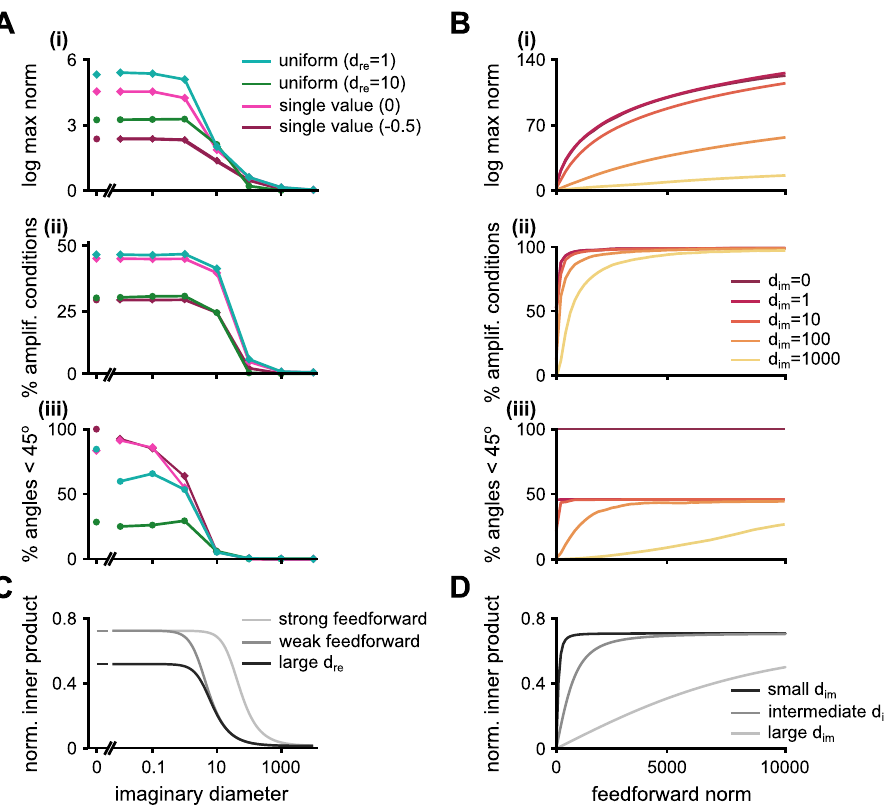
Fig 3. Effects of manipulating the spectrum and the feedforward norms. A , Maximum response norm for the preferred initial condition (i) , percentage of directions whose norm is amplified more than 50% (ii) , and the percentage of angles (between pairs of eigenvectors) that are less than 45˚ (iii) . Every line is a function of the imaginary diameter. We plot four real distributions. Light green: a uniform distribution in which all real parts are distributed uniformly in the interval ( − 0.5, 0.5). Dark green: a uniform distribution in which all real parts are distributed uniformly in the interval ( − 9.5, 0.5). Light pink: a single valued real distribution in which all real parts are equal to zero. Dark pink: a single valued real distribution in which all real parts are equal to − 0.5. In all cases the network size is N = 200 and the feedforward Frobenius norm is fixed at 75. d re indicates the diameter of the uniform distribution of the eigenspectrum’s real part. B , Same as panel A, but plotted as a function of the feedforward Frobenius norm. Different colours correspond to 5 different spectra; all spectra have fixed single-valued real distributions (equal to zero) and different imaginary diameters. d im indicates the diameter of the uniform distribution of the eigenspectrum’s imaginary part. C , Normalised inner product between vectors from a simplified 3-by-3 upper triangular matrix (Eq 4) as a function of the imaginary diameter ( β in Eq 4) for three conditions: “strong feedforward” ( ϕ norm = 30 and α − γ = − 0.3); “weak feedforward” ( ϕ norm = 3 and α − γ = − 0.3); and “large d re ” ( ϕ norm = 3 and α − γ = − 3). D , Same as panel C, but plotted as a function of the feedforward norm for three different conditions: “small d im ” ( β = 100 and α − γ = 0); “intermediate d im ” ( β = 1000 and α − γ = 0); and “large d im ” ( β = 10000 and α − γ = 0).